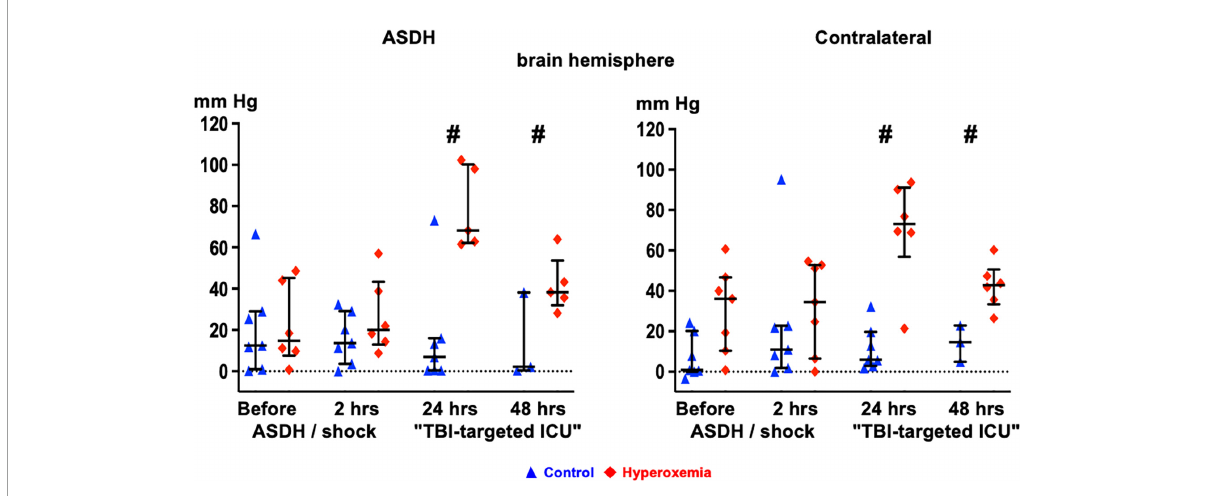
FIGURE3 Time course of brain tissue O 2 partial pressure (P bt O 2 ) in the blood-injected (“ASDH”, left panel) and the contralateral (right panel) brain hemisphere in the control animals (blue triangles) and the targeted hyperoxemia group (red diamonds). Presented are individual data points, median and interquartile range; # denotes p < 0.05 vs. control. Note: At 24 h of “TBI-targeted ICU care” two control animals had already died. However, since these animals had to be euthanized at less than 2 h before the scheduled time point at 24 h of ICU care, the immediate pre-mortal P bt O 2 values recorded at that time point were used as readings for “24 hours of TBI-targeted ICU care”.